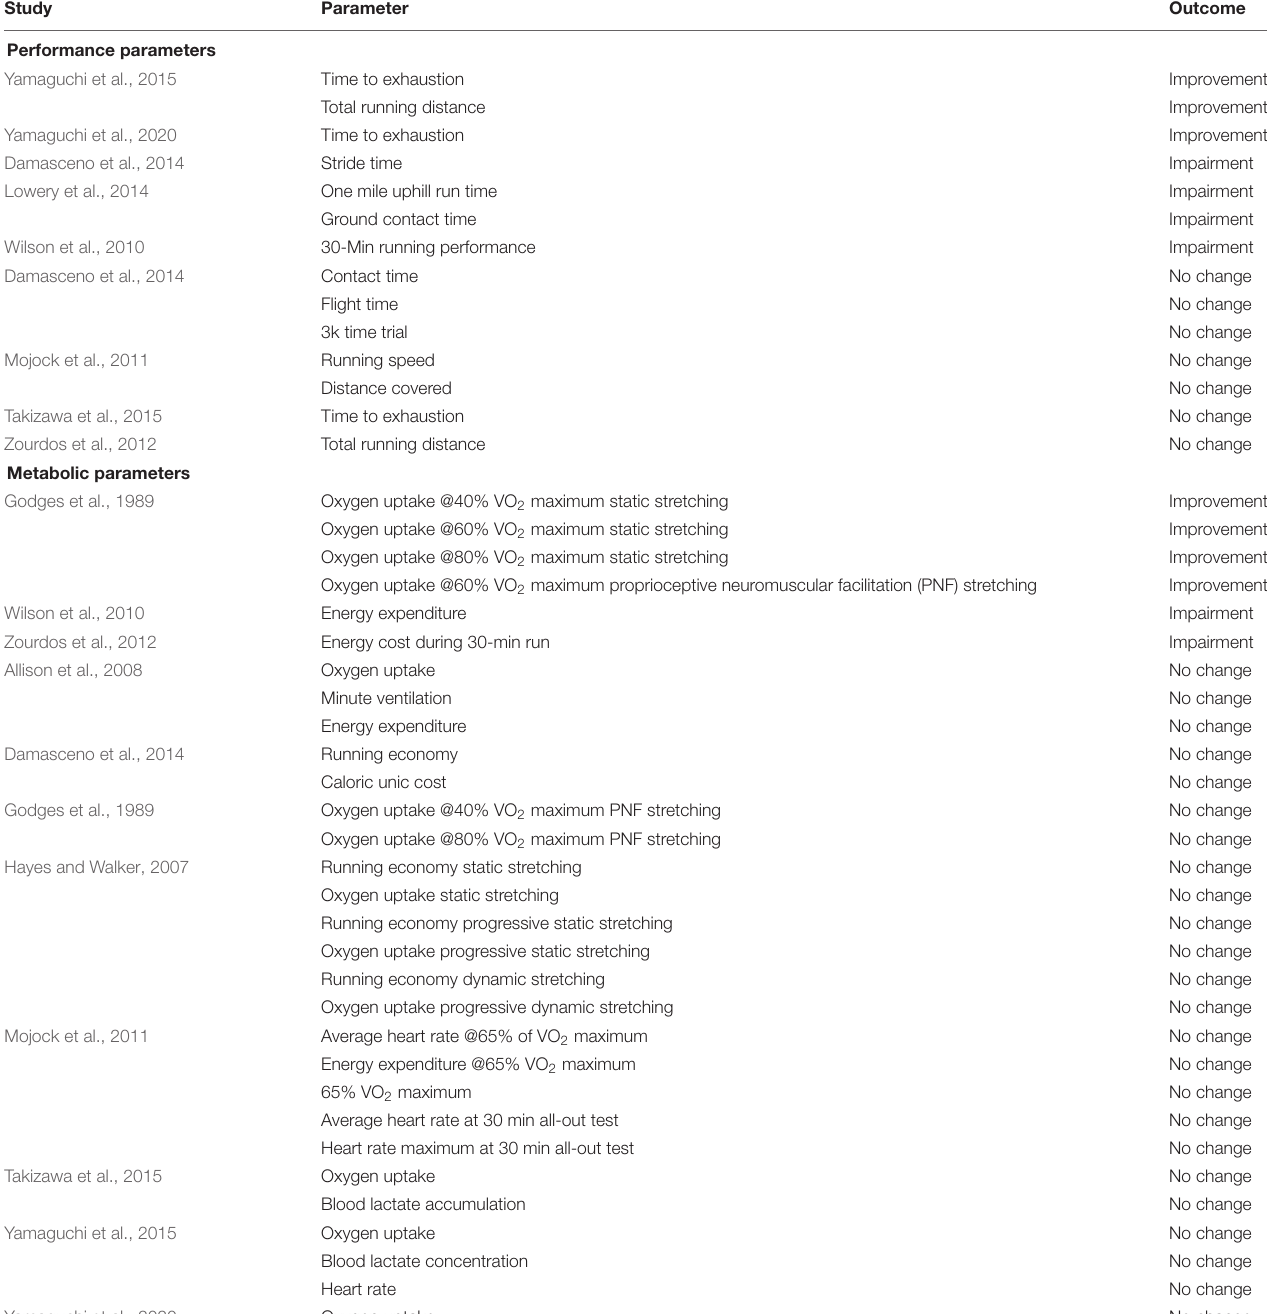
TABLE 2 | Direction of change in running performance or metabolic parameters of the included